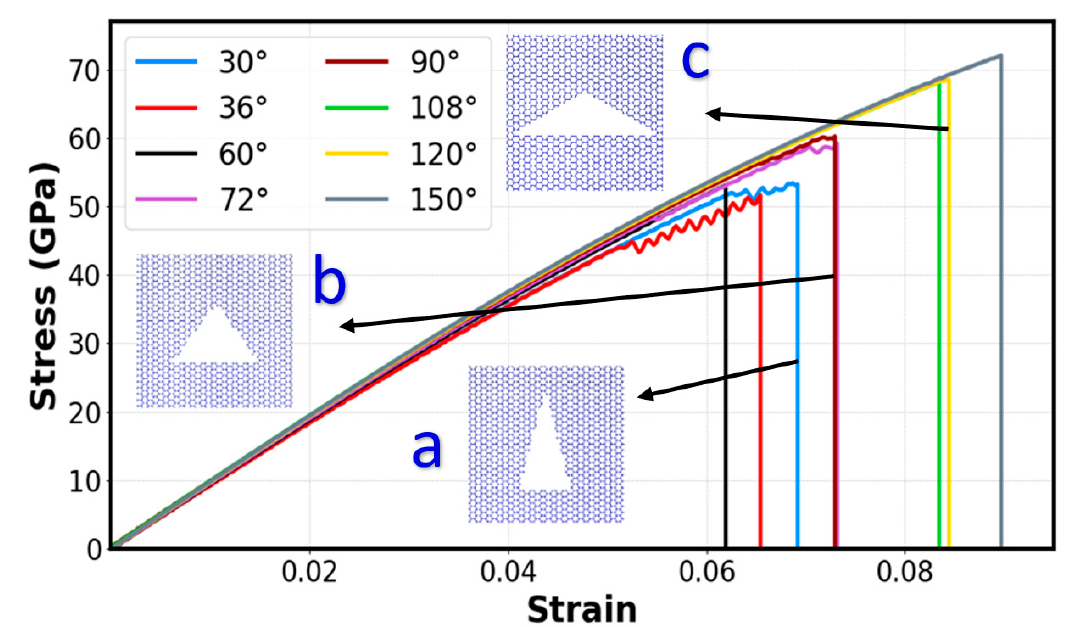
Figure 2. Stress–strain relationships of the eight SLGSs pre-cracked in the shape of an isosceles triangle with different vertex angles ranging from 30° to 150° compared with that of pristine graphene. The tensile simulations were performed under the following conditions: The temperature was 300 K. The pressure was 0.0001 GPa (1 atm). The strain rate was 10 9 s − 1 . The model I loading was applied along the x axis (armchair direction). The insets were snapshots for the angles of ( a ) 30°, ( b ) 72°, ( c ) 120°.